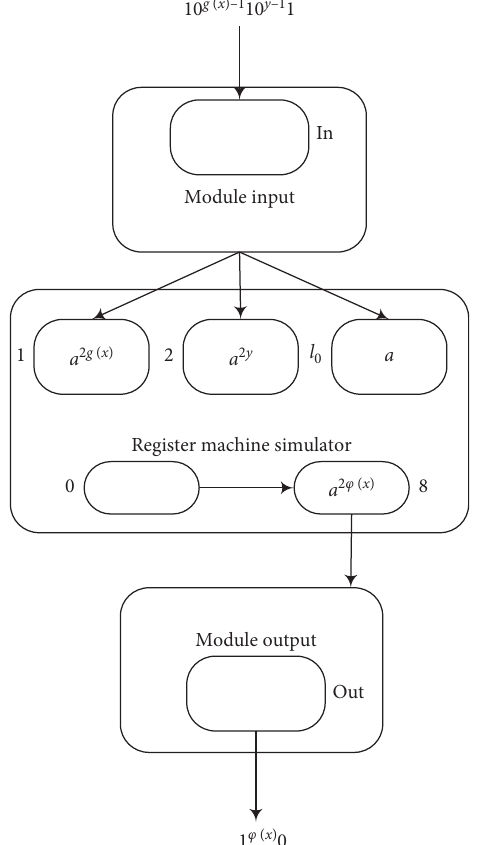
Figure 9: A framework of a DSN P system as computing functions.